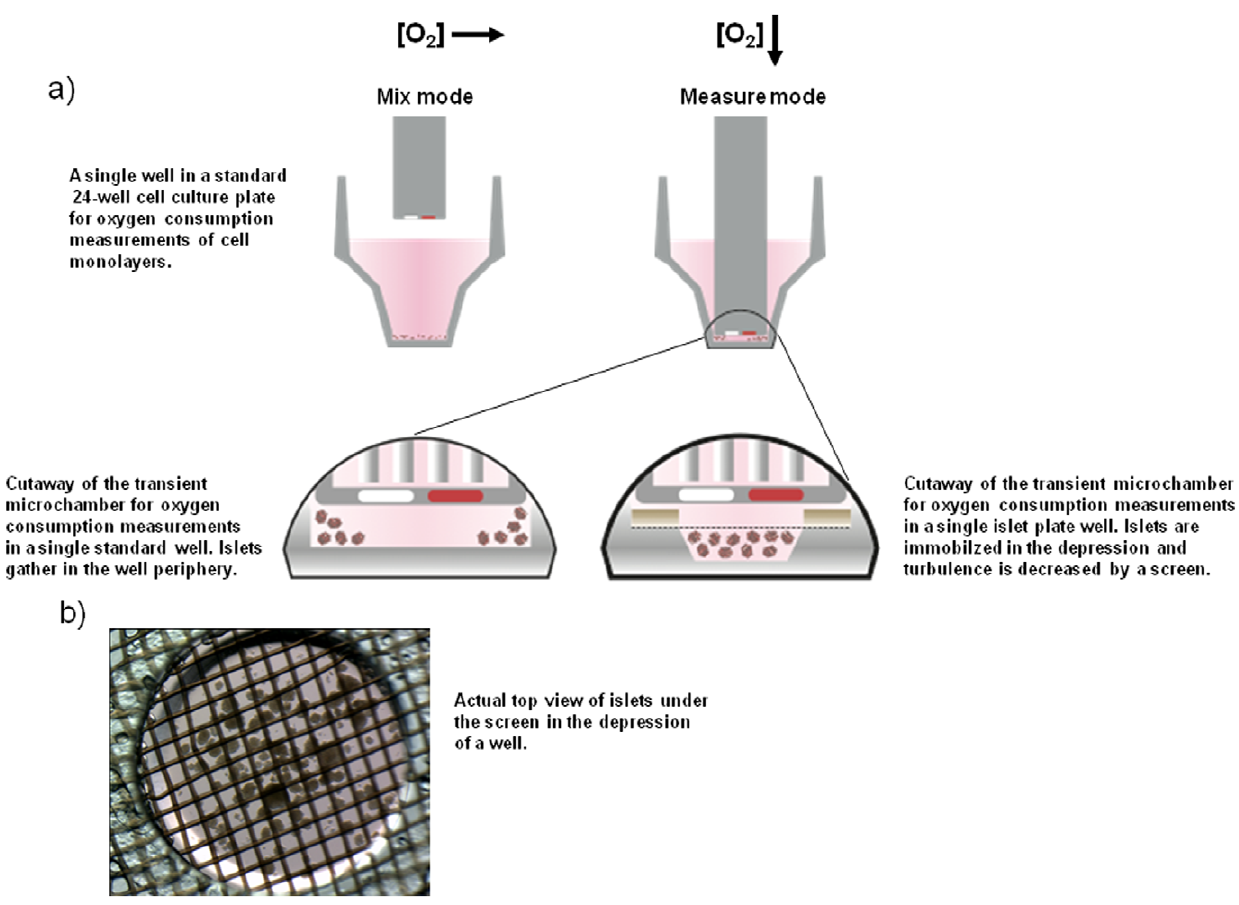
Figure 1. Measuring islet oxygen consumption in a high throughput format. A) Islet plate development. The XF24 measures oxygen consumption from monolayers of adherent cells in a 24 well cell culture plate format. Oxygen consumption is measured with probe heads coated with oxygen sensitive fluorophores that are optically read (marked white and red). During the ‘‘measure’’ mode a volume of only a few micro-liters is formed. In this minute volume oxygen tension rapidly drops which enables OCR calculations. In ‘‘mix’’ mode, the probe head moves up and down, reoxygenating the cells and exposing them to injected compounds. The wells with flat bottoms, originally designed for cell monolayers, proved inadequate for islets as they gathered in the well periphery, too far from the probe head (left panel). To address this problem, an islet plate with a central depression covered by a screen was developed. This trapped the islets while still maintaining sufficient media access (right panel). The screen consists of a polycarbonate ring attached to a nylon net with 50 m m pore size. B) Image of islet plate well. After experiments each well of the 24-well plate was imaged and the images were used for calculating OCR per islet and to measure islet diameter. The islet images were then used to obtain an exact islet count per well and to measure islet diameter. C) Flat bottom (V7) plates are not suitable for islets. 70 islets were seeded per well. Traces recorded from separate wells in a plate are shown. Note the large data variation and that subsequent to 20 mM glucose injection the OCR only increase in one well out of four. D) Islet plate reduces data variability. As islet seeding could vary and thus the absolute OCR, data from each well was often normalized to its initial steady state values before any compound was injected. Traces from islets in 3 mM and 20 mM glucose are shown with absolute (left) and normalized rates (right); note the stability over 2.5 hours. Subsequent to 20 mM glucose injection (after 1 st data point) the OCR increased in all the wells. Islets that stay in 3 mM glucose do not display any major change in OCR. E) Initial measurements are unstable. OCR in the islet plate showed an initial drift during the first 1–2 measurements (dashed square), therefore these data points where always omitted. F) Experimental set up – bioenergetic principles. Respiration recorded may be deciphered by using drugs acting on the mitochondrial inner membrane/ complexes. Oligomycin blocks complex V and remaining respiration represents the proton leak. Rotenone/Myxothiazol blocks complexes I/III and remaining respiration is non-mitochondrial. FCCP stimulation shows maximal respiratory capacity. Nutrient stimulation (glucose) may be used in addition to these drugs to study the effect of nutrient